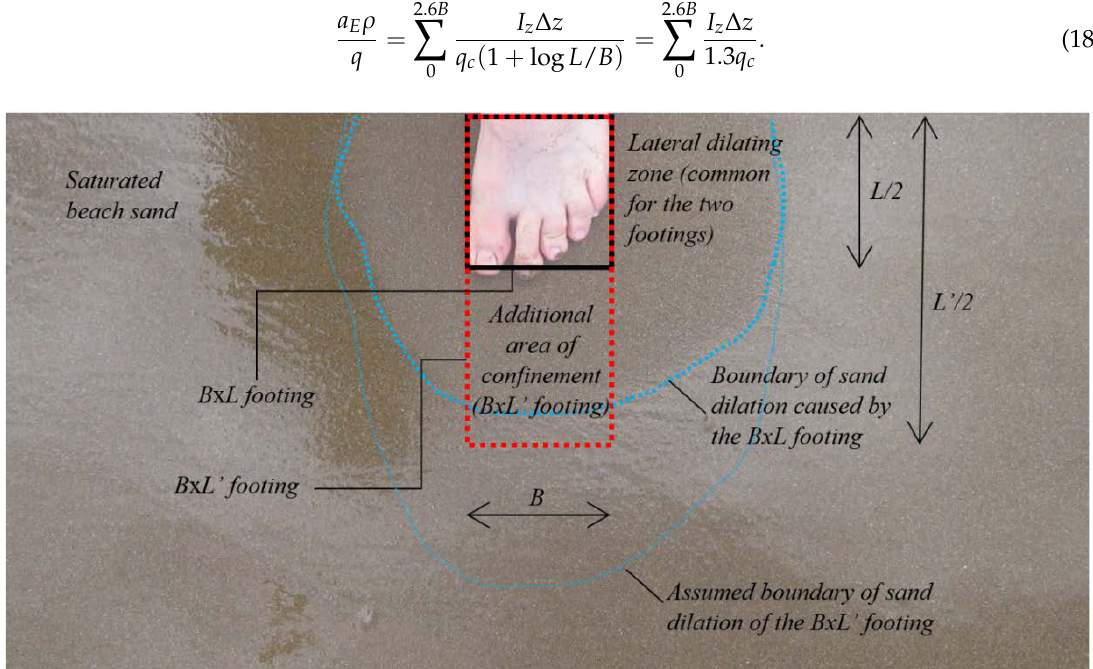
Figure 14. Dilation of sand around the footing. Pictures showing the case of foot on saturated beach sand. A longer footing of the same width increases the confinement of sand and, in turn, its modulus. The favorable effect of the second dimension of footing weakens as L increases.